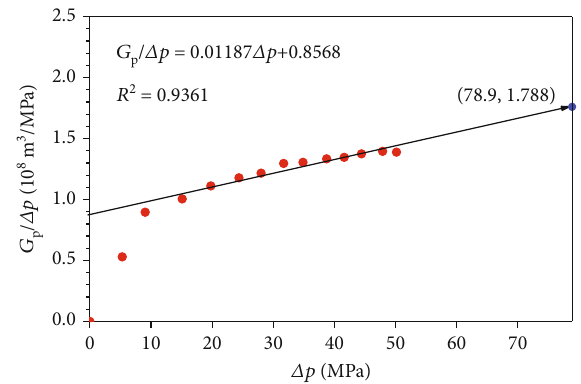
Figure 4: Reserves of Anderson “ L ” gas reservoir calculated by the method of gas production of cumulative unit pressure drop.